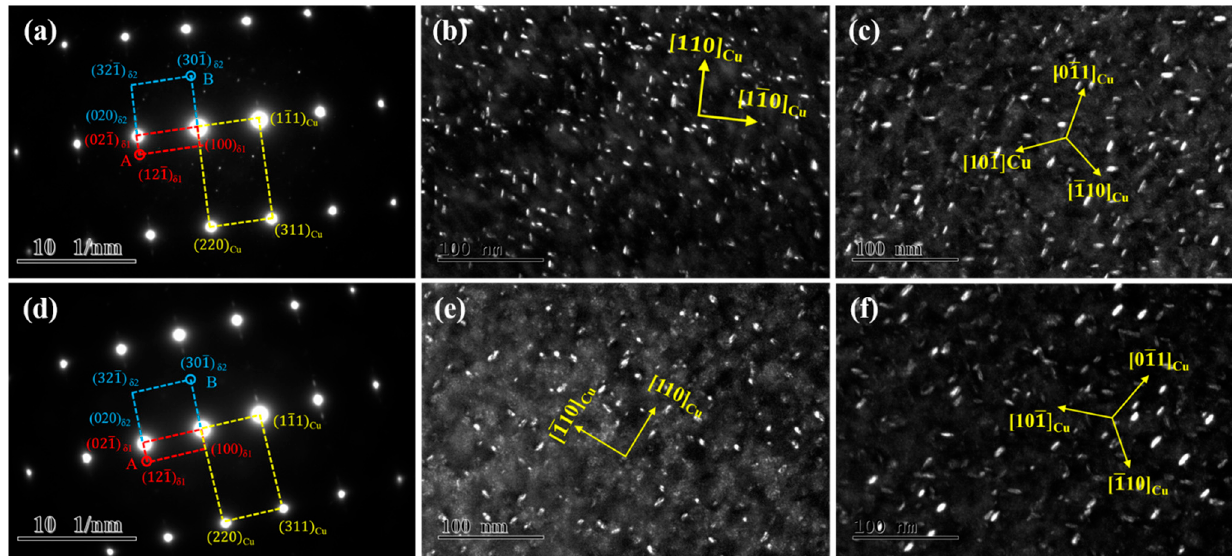
Figure 5. TEM images of the NC-3 and NC-4 alloys at the peak aging state. ( a – c ) NC-3 alloy; ( d – f ) NC-4 alloy; ( a , d ) SAED of [112] Cu ; ( b , e ) dark-field of [001] Cu ; ( c , f ) dark-field of [111] Cu .